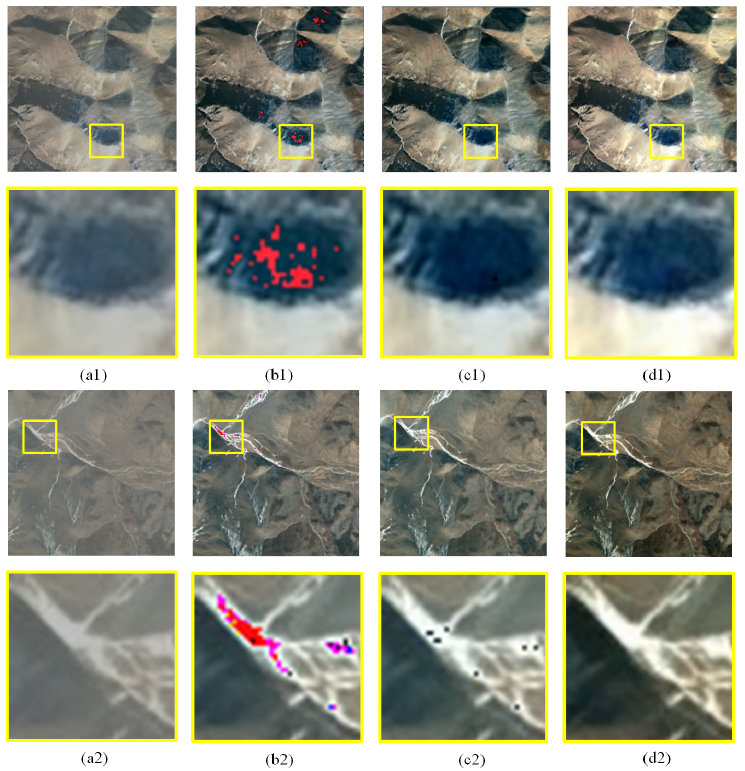
Figure 7. The thin cloud removal results of two RICE1 samples reconstructed in different color spaces: ( a1 , a2 ) input cloudy image, ( b1 , b2 ) output images reconstructed in RGB color space, ( c1 , c2 ) output images reconstructed in YUV color space, and ( d1 , d2 ) reference cloud-free image.